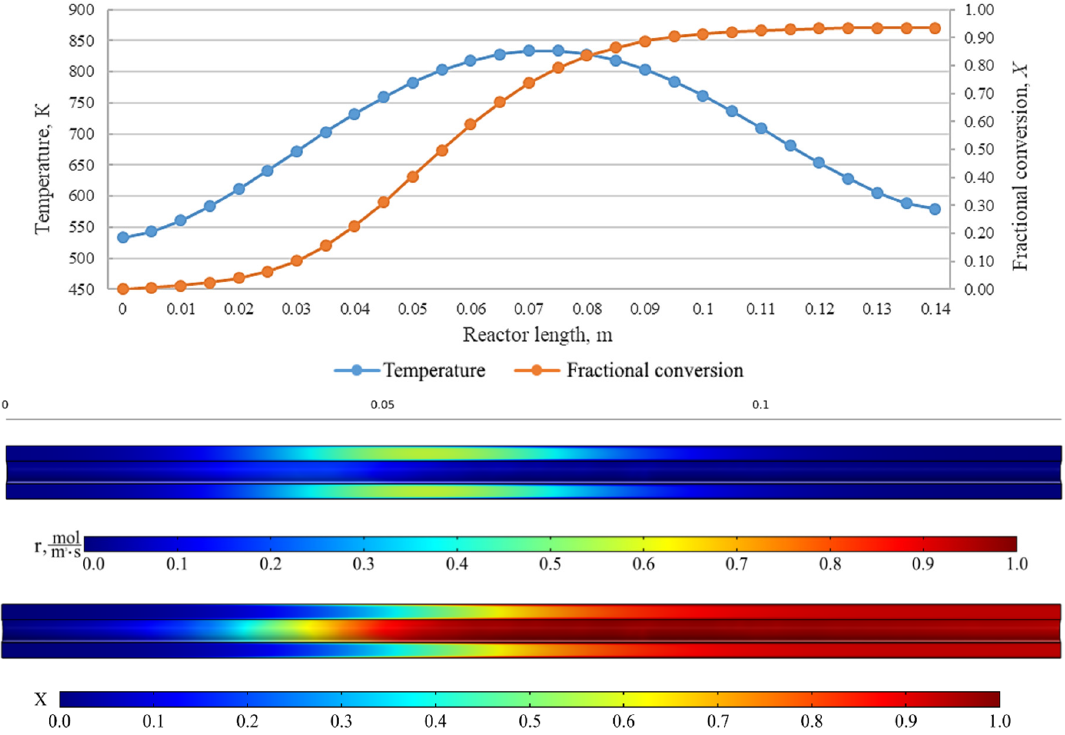
Figure 20. From top to bottom: temperature and fractional conversion curves, profiles of the reaction rate and fractional conversion along the reactor length for the experiment cyGOm_550_120 (Tmax = 550 °С , 𝑉(cid:4662) = 0.05 L/min).